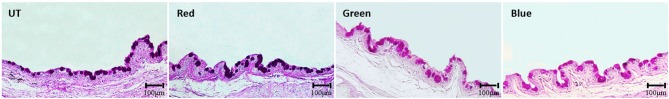
Periodic acid Schiff stains of representative conjunctival specimens in the untouched (UT), red, green, and blue groups at day 10.